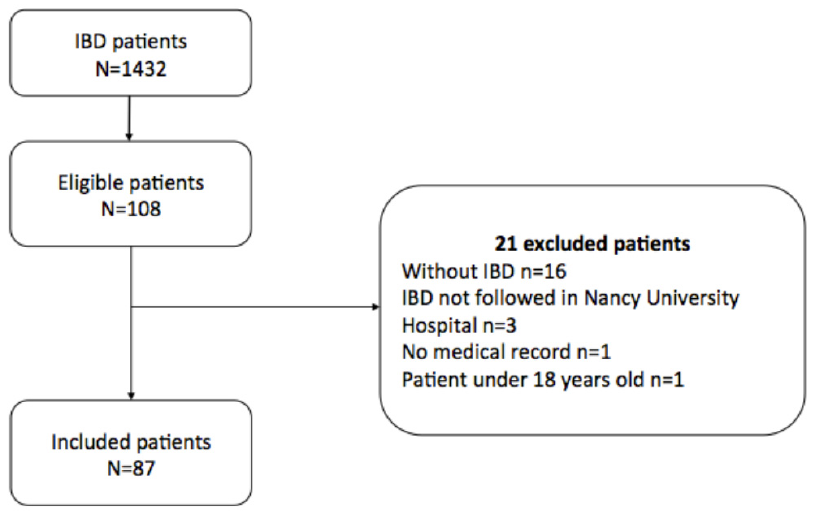
Figure 1. Flow Chart.